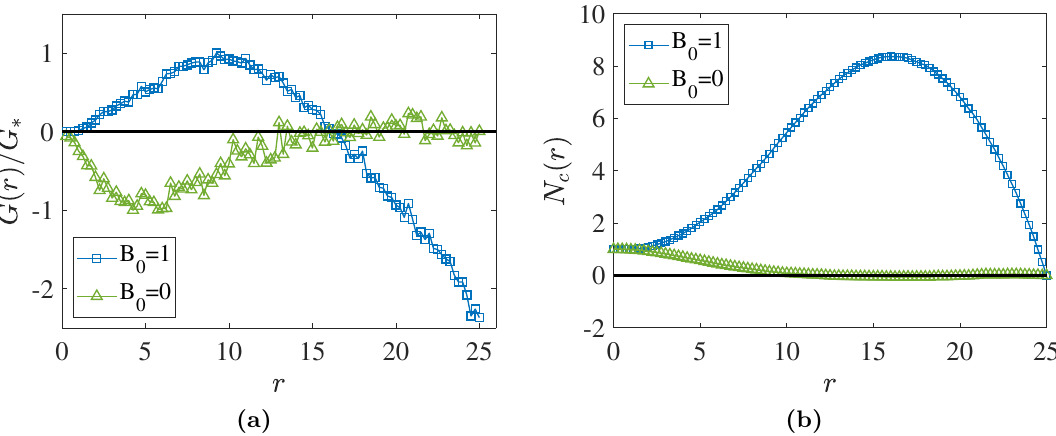
Figure 4. Vortex correlation functions G ( r ) /G ∗ and net vorticity N c ( r ) with and without magnetic fields in the initial state. (a) Vortex correlation functions G ( r ) / | G ∗ | for B 0 = 0 and B 0 = 1 , where G ∗ are scaling constants. From the different behaviors of G ( r ) , we can clearly identify the positive correlations between vortices in the FTM ( B 0 = 1 ), while the vortices are negatively correlated in KZM ( B 0 = 0 ); (b) Net vorticity N c ( r ) inside a square for B 0 = 0 and B 0 = 1 . N c ( r . 16) > 1 indicates the positive correlations between vortices for B 0 = 1 , while N c ( r ) < 1 indicates negative correlations for B 0 = 0 . Quench rate for both panels is τ Q = 20 and we have made 200 times of independent simulations for both